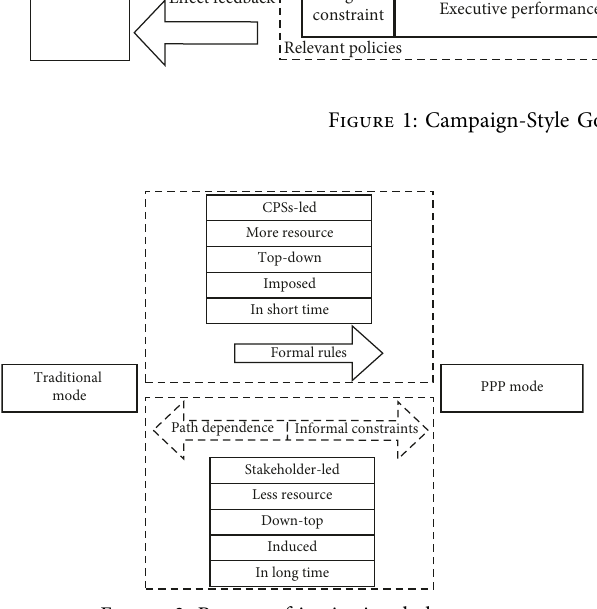
Figure 2: Process of institutional